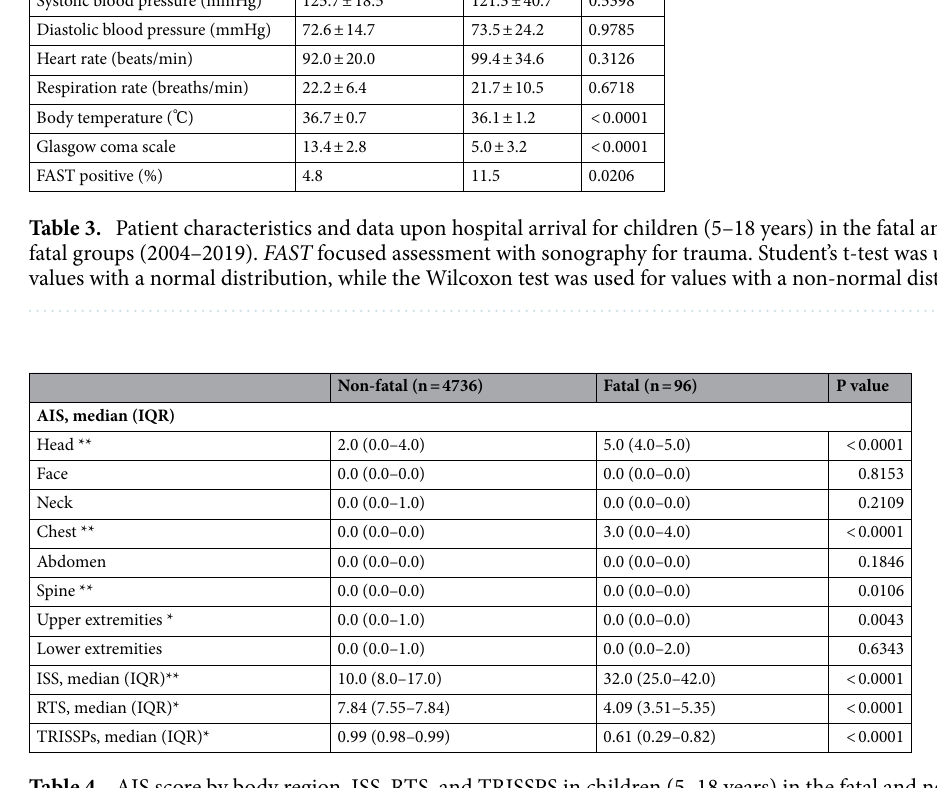
Table 4. AIS score by body region, ISS, RTS, and TRISSPS in children (5–18 years) in the fatal and non-fatal groups (2004–2019). AIS abbreviated injury scale, ISS injury severity score, IQR interquartile range, RTS revised trauma scale, TRISSPS trauma and injury severity score probability of survival. *The median value in the non-fatal group was significantly higher than that in the fatal group. **The median value in the non-fatal group was significantly lower than that in the fatal group. Student’s t-test was used for values with a normal distribution, while the Wilcoxon test was used for values with a non-normal